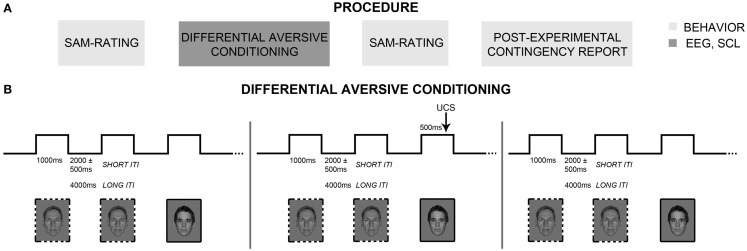
Experimental procedure and differential classical conditioning. (A) The experimental procedure consisted of three different parts: The first and third parts included evaluative (SAM-ratings) and behavioral (post-experimental contingency report) measures of classical conditioning (boxes in light gray). In the second part, differential aversive conditioning was carried out, while electroencephalography (EEG) and skin conductance changes were recorded (box in dark gray). (B) Differential aversive conditioning consisted of three continuous phases (habituation, acquisition, extinction). During habituation and extinction, all conditioned stimuli (CSs) were shown without presentation of the aversive electric stimulation (UCS). During acquisition, four of the eight neutral faces (CS+; solid frame) were paired four times each with the UCS, while the other four neutral faces (CS−; dashed frame) were also shown four times, but never paired with the UCS. During all three phases, trials were shown with either short or long inter-trial intervals (ITIs) to allow for multiple repetitions in EEG but also for sufficient autonomic recovery. Note that in accordance with NimStim publication guidelines, only one model (#28) from the NimStim database is displayed. The other image shows one of the authors, but was not used as stimulus in the present study.